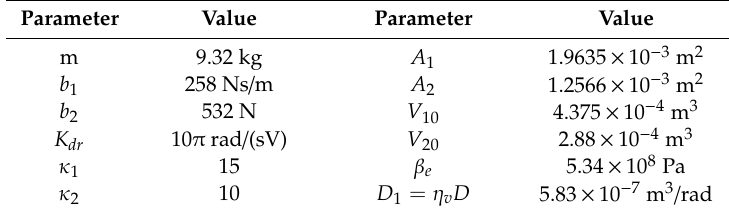
Table 2. Parameters of the